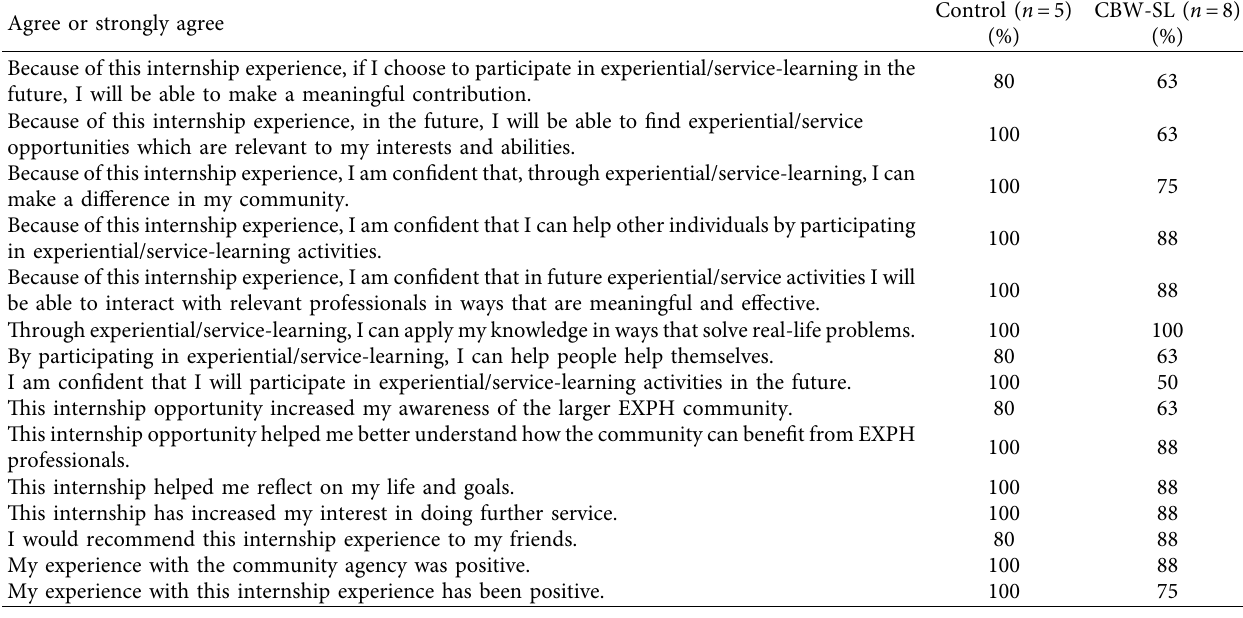
Table 1: Self-efficacy and satisfaction